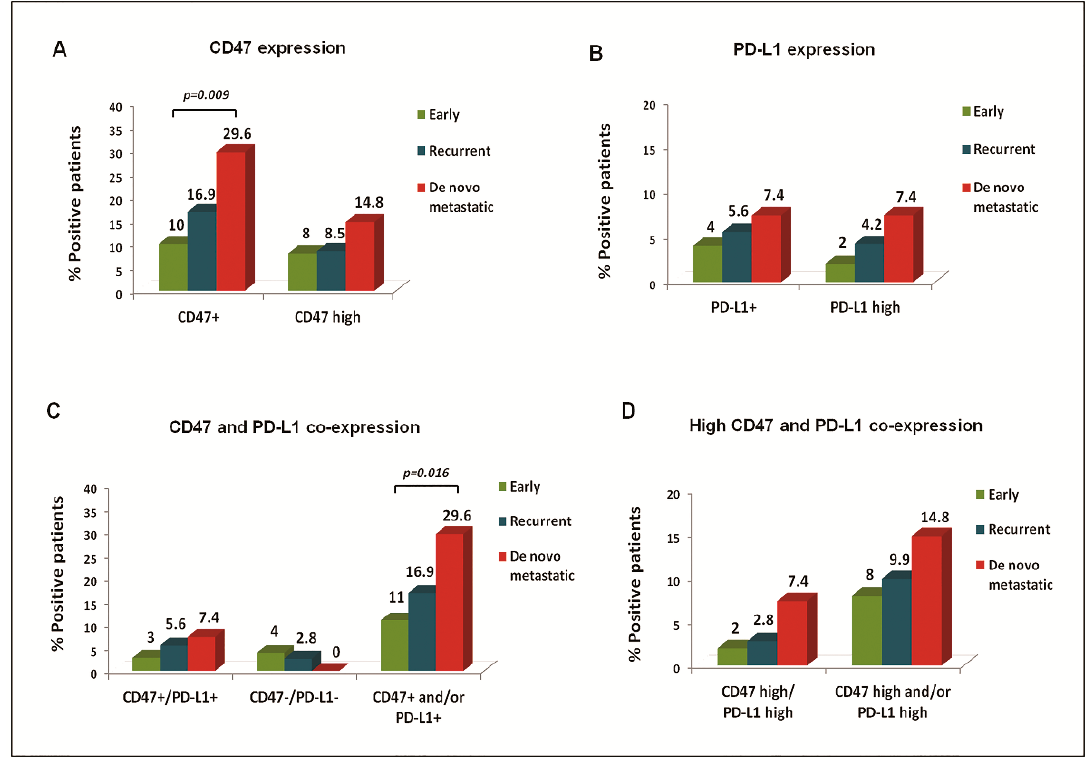
Figure 1. CD47 and PD-L1 expression rates on circulating tumor cells (CTCs) of BC patients. Frequency of distinct CTC subsets among patients with early, recurrent, and de novo metastatic BC. Percentage of patients with CTCs presenting ( A ) CD47 or CD47 high expression, ( B ) PD-L1 or PD-L1 high expression, ( C ) CD47 and PD-L1 co-expression, and ( D ) CD47 high and PD-L1 high co-expression.